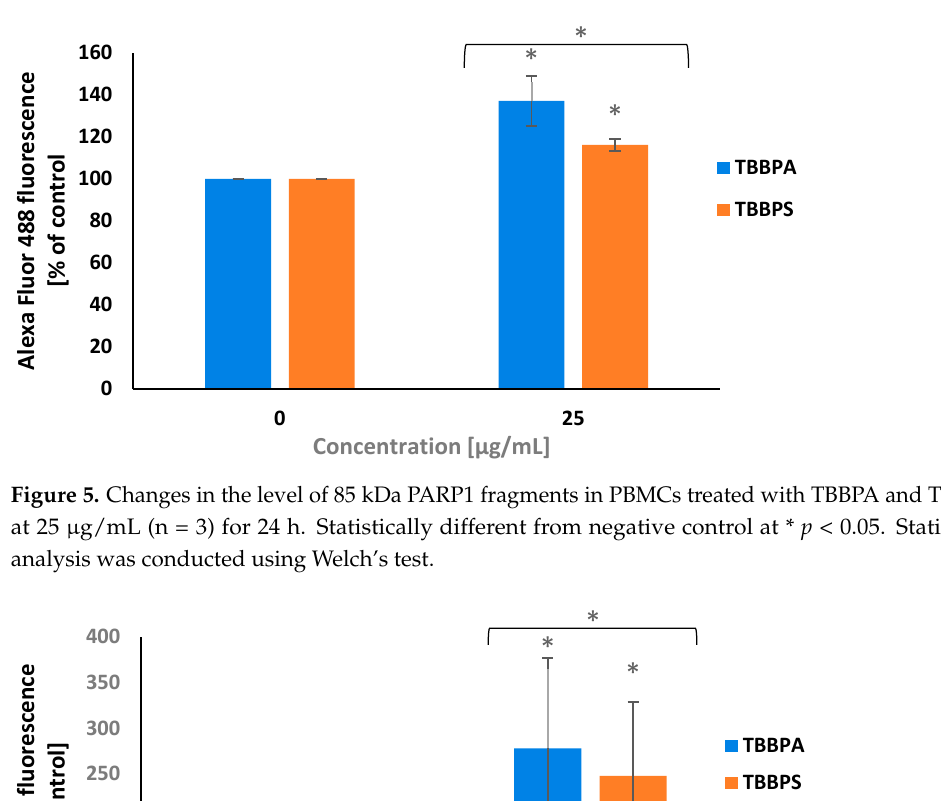
Figure 5. Changes in the level of 85 kDa PARP1 fragments in PBMCs treated with TBBPA and TBBPS at 25 µg/mL (n = 3) for 24 h. Statistically different from negative control at * p < 0.05. Statistical analysis was conducted using Welch’s test.